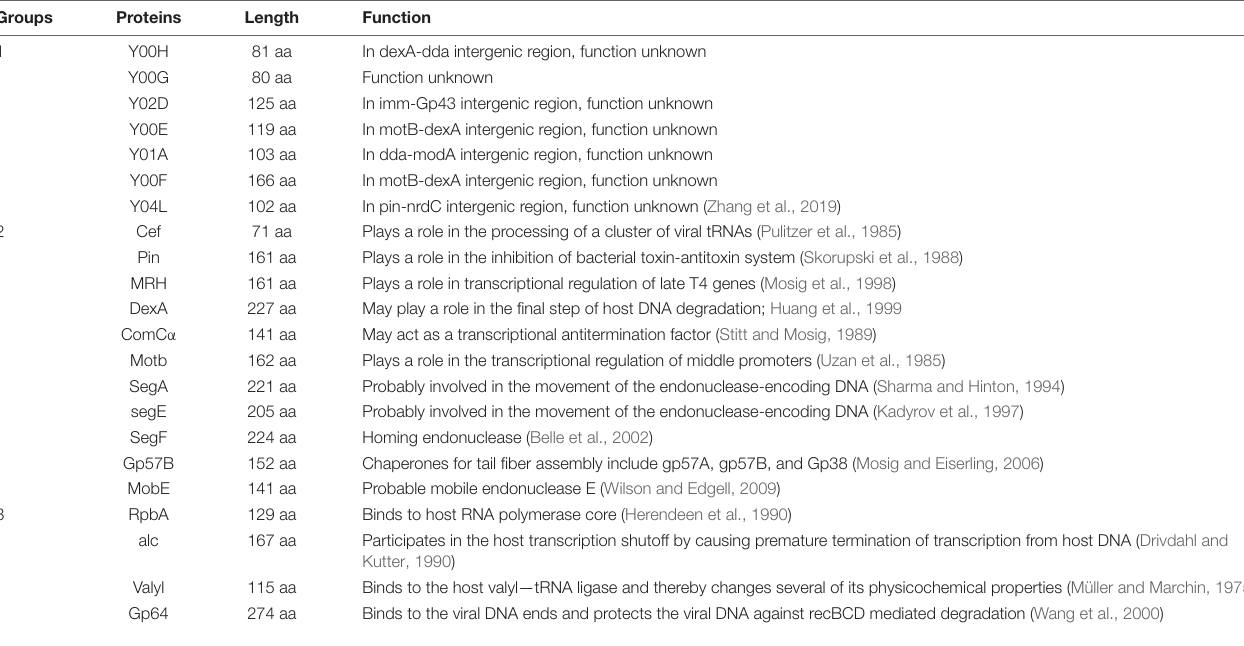
TABLE 1 | Summary of the 22 proteins selected for the initial studies presented in this study, including their respective lengths and known functions.